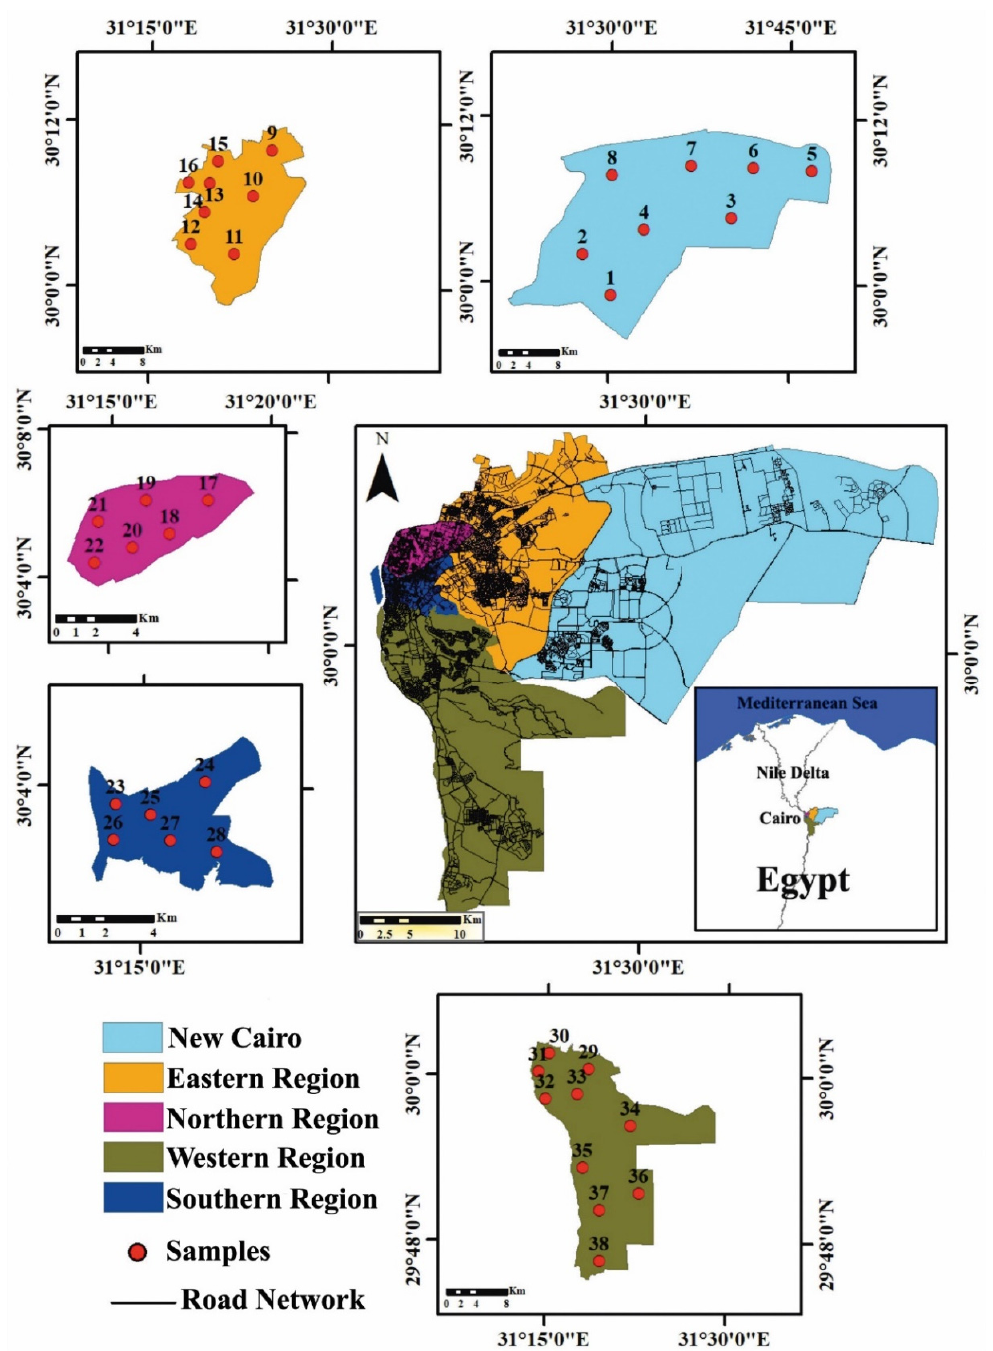
Figure 1. Map displaying Cairo City and its administrative regions and sampling site’s locations. Cairo City has a typical Mediterranean climate, with different temperatures through seasons: winter 14 ◦ C, spring 21 ◦ C, summer 36 ◦ C, and fall 23 ◦ C. Most of the